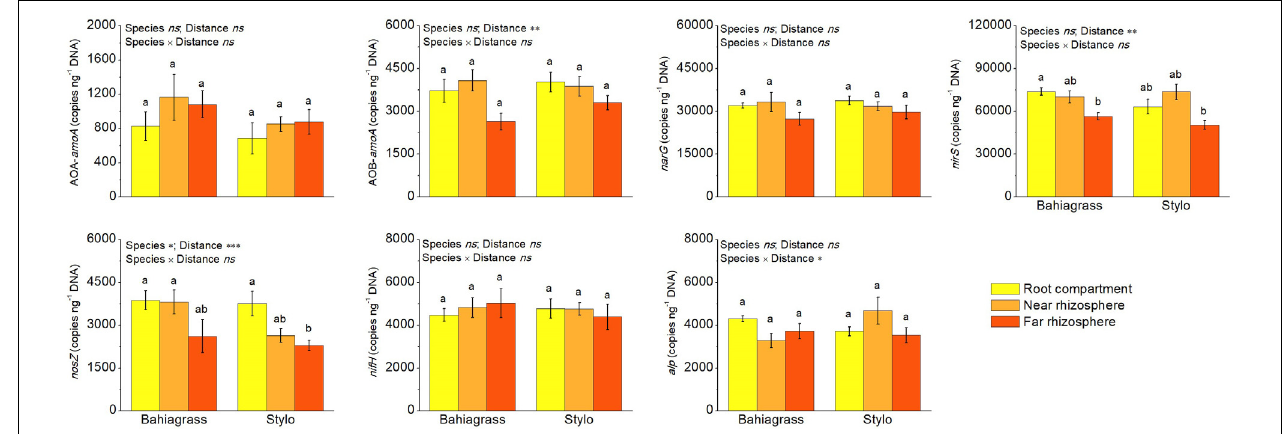
FIGURE 5 | The abundances of bacterial functional genes as affected by plant species and distance. Bars with different letters are significantly different (Tukey HSD test, P < 0.05). Near rhizosphere and far rhizosphere indicate the rhizosphere space of 0–5 mm and 10–15 mm apart from rhizoplane, respectively. Bahiagrass, Paspalum natatum ; Stylo, Stylosanthes guianensis .